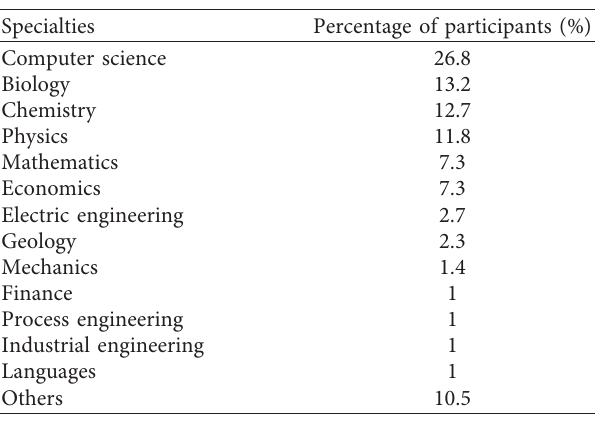
Table 3: Distribution by specialty.